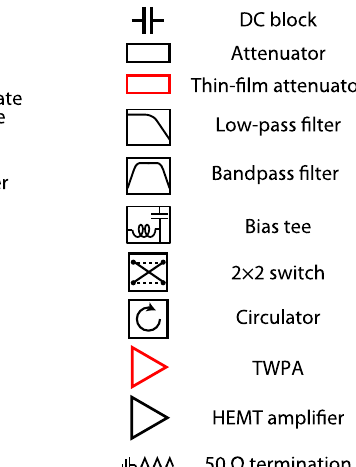
TABLE II. Qubit parameters on device II. f is the maximum frequency (sweet spot) and E max is the coupling of qubit to the corresponding edge state. The readout resonator at frequency f energy of the qubit. g E qubit with coupling strength g . T 1 ( T (cid:2) 2 ) is the lifetime (Ramsey coherence time) of a qubit measured at the sweet spot. RO